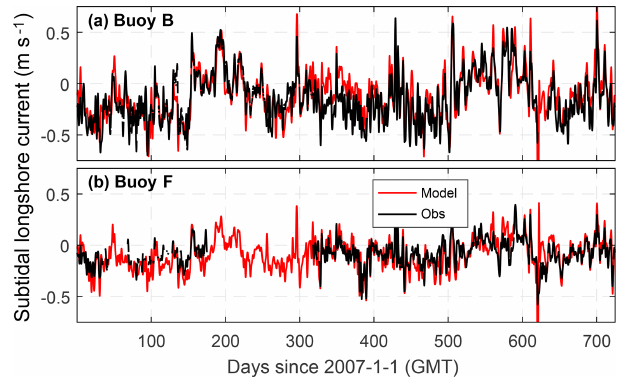
Figure 8. Comparison of the subtidal east–west surface shelf cur- rent between the model (red line) and observations (black line) at two TABS buoys (see Fig. 2 for their